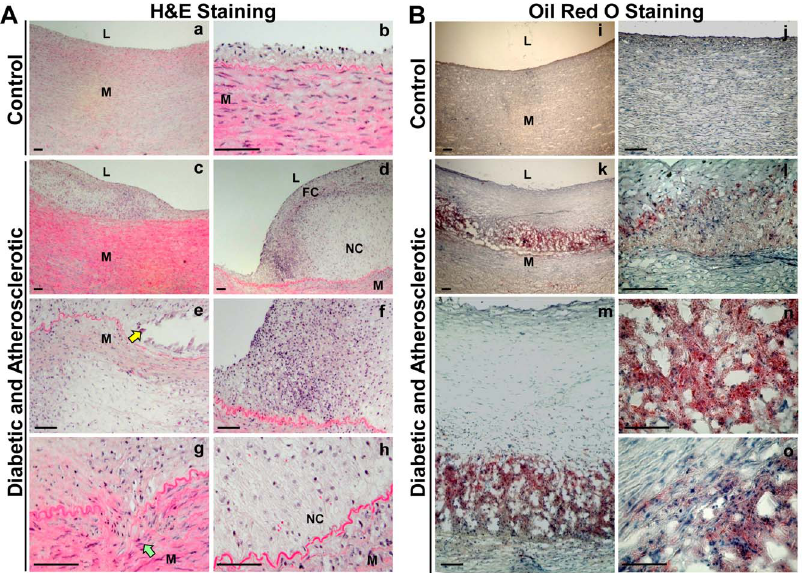
Figure 2. Characterization of human-like, complicated atherosclerotic phenotypes in the well-established porcine model of diabetes-accelerated atherosclerosis. Histopathologic characteristics of early/intermediate lesions and advanced plaques in diabetic and atherosclerotic pigs. Representative H&E staining ( A ) and Oil Red O staining ( B ) of aortic sections of control pigs ( a,b , i and j ) and diabetic, atherosclerotic pigs ( c–h and k–o ) are shown (scale bars, 100 m m). H&E-staining ( d–h ) showed a human-like fibroatheroma with a fibrous cap at the shoulder and a necrotic lipid core at the base of lesion (L=lumen, FC=fibrous cap, NC=necrotic lipid core, and M=media). Note the clear space (yellow arrow) which represents an area of cholesterol crystals removed during tissue processing ( e ) and smooth muscle cell migration from the media to the intima (green arrow) ( g ). The advanced plaques have necrotic lipid cores containing large numbers of cholesterol crystals ( m , n and o ).